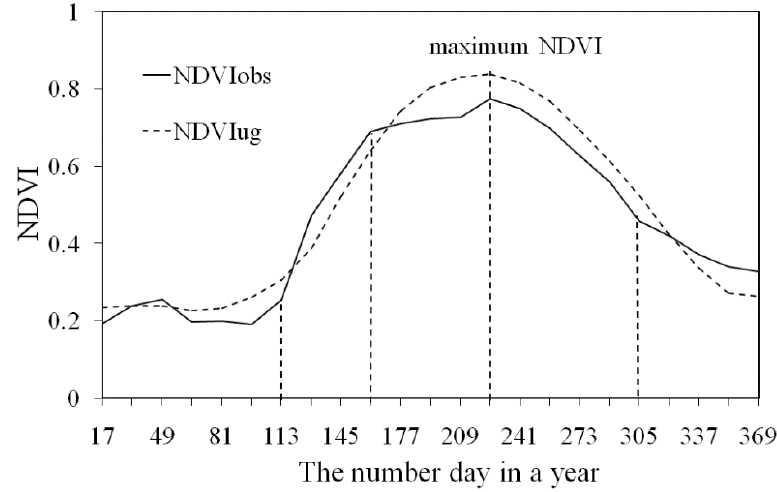
Figure 3. Comparison of observed NDVI of one pixel with the NDVI of non-grazing areas (the solid line named NDVI obs is the observed NDVI value of one pixel which would be judged whether it is used for grazing, and the dot line curve is the trend line of NDVI in non-grazing areas). RI judges whether one pixel is used for grazing through comparing the NDVI value of the pixel with the NDVI of non-grazing areas. For one pixel, if only RI is less than one or more than one, we could not simply recognize this pixel as a grazing pixel or a non-grazing pixel. For example, as presented in Figure 3, before the vegetation NDVI reaches the maximum value, the NDVI of the 113th day is 0.2522, less than NDVI value (0.3038) of non-grazing areas, and the RI in 113th is less than one. It might be unreasonable to determine the pixel as the grazing pixel at 113th day just only relying on RI. Since RDI is about 1.43, there might be no livestock grazing during the 97th–113th day after grazing at the 97th day. In addition, after the vegetation NDVI reaches the maximum value, the RI at the 305th day is also less than one, and RDI is more than one These two indices combined to